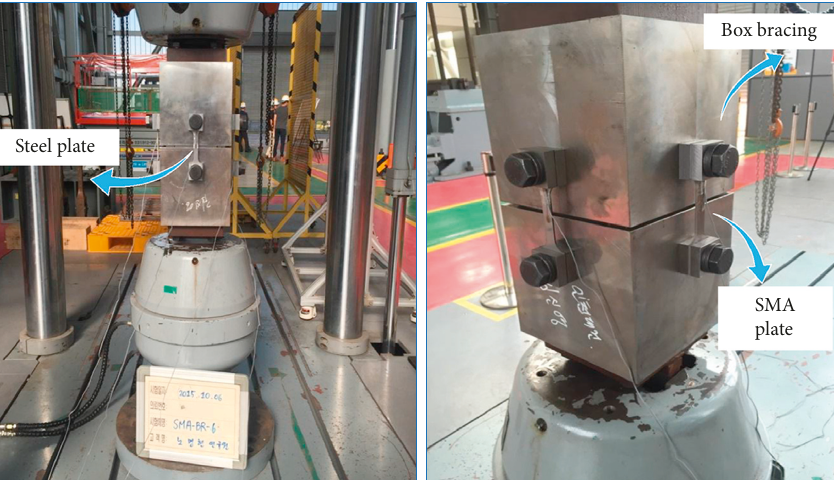
Figure 5: Experimental test setup.